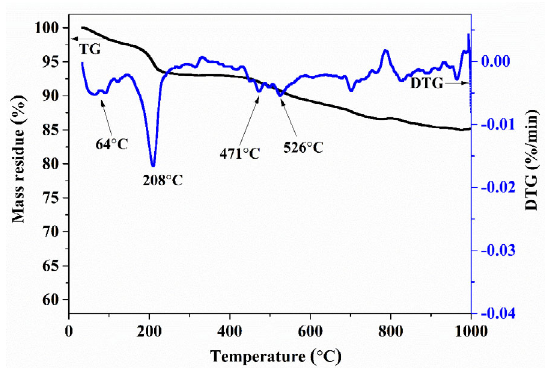
Fig. 4 TG and DTG (the first derivative of the TG) curves of the ceramization process of ABZ-1.